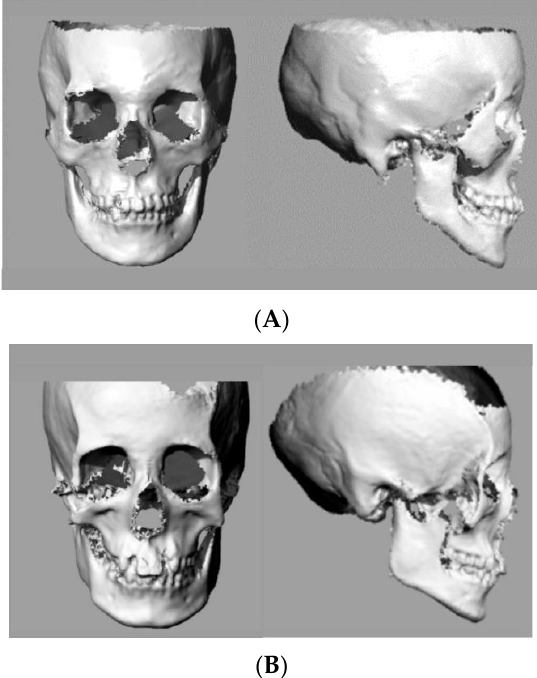
Figure 1. Measurement variables. ( A ) Skeletal angular measurements: 1, facial angle; 2, angle of